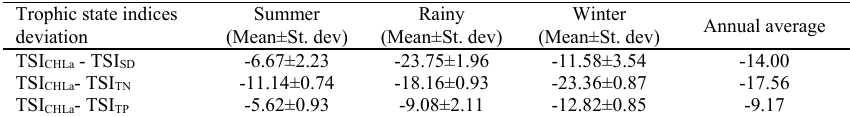
Table 6. Deviations in TSI s values in different season with annual average